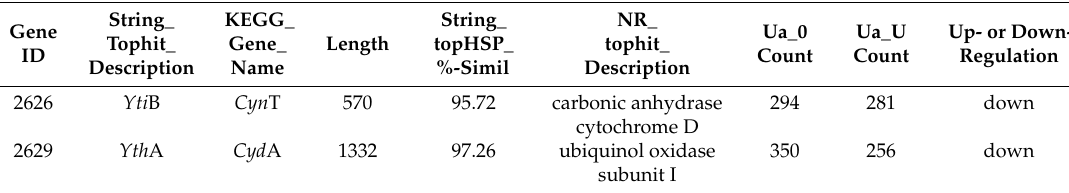
Table 2. The expression characteristics of yti B and yth A